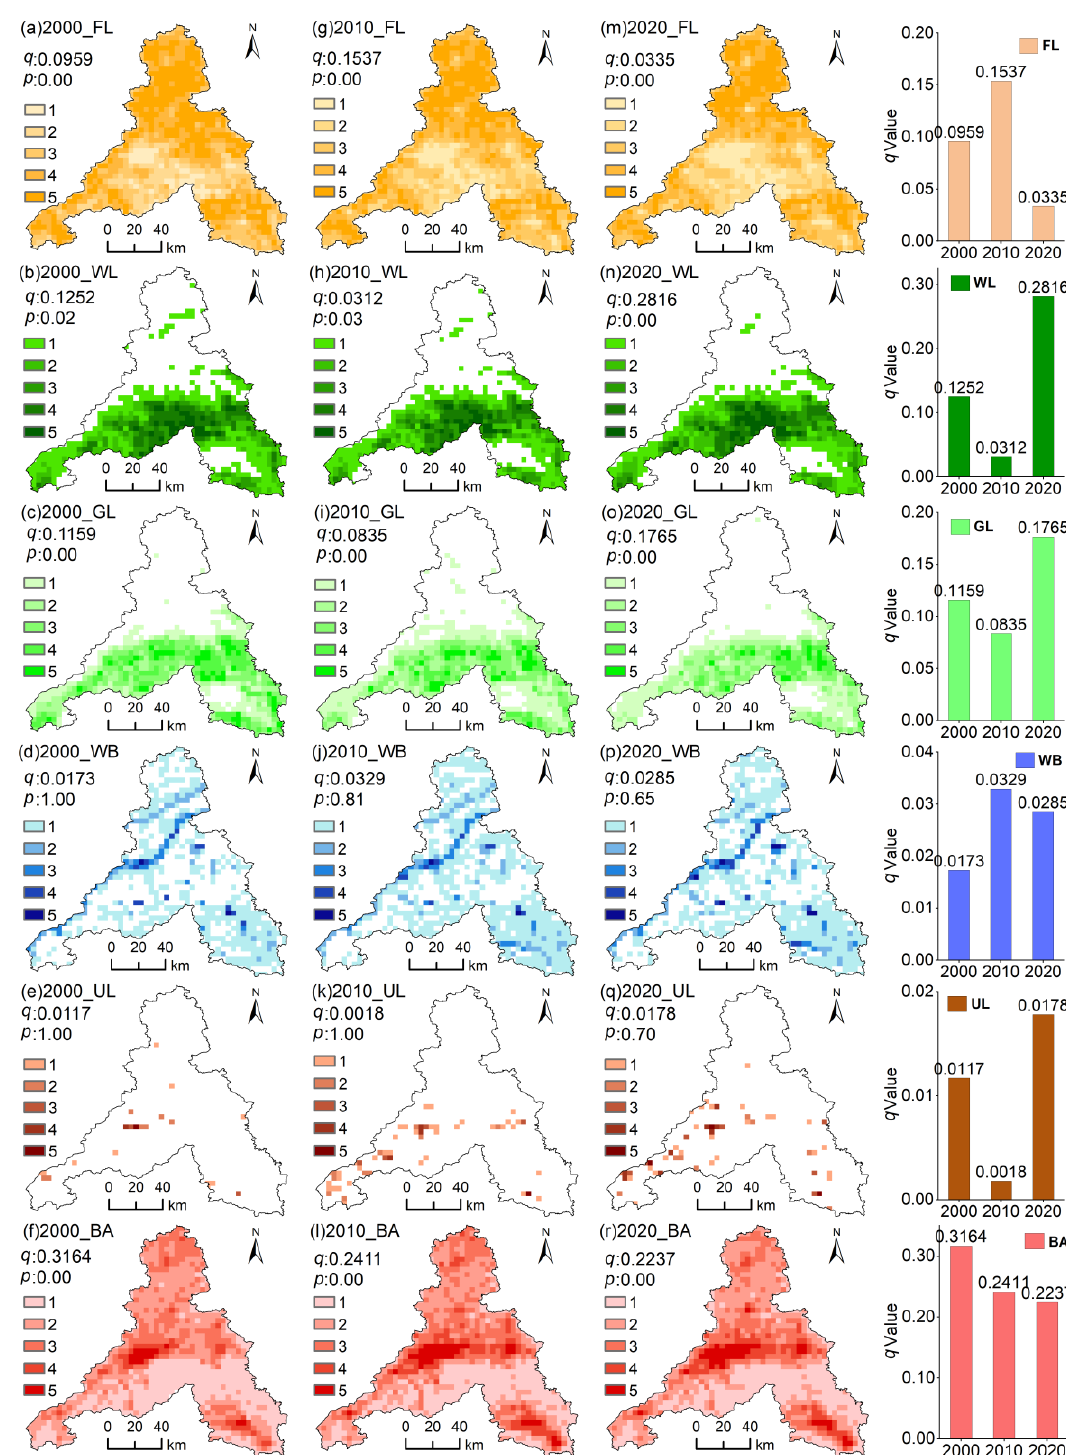
Figure 9. Spatial distribution of impact factors and factor detection results: ( a – f ) are the spatial distribution of impact factors and factor detection results in 2000; ( g – l ) are the spatial distribution of impact factors and factor detection results in 2010; ( m – r ) are the spatial distribution of impact factors and factor detection results in 2020. The rightmost column displays the variation in q -value of each impact factor with